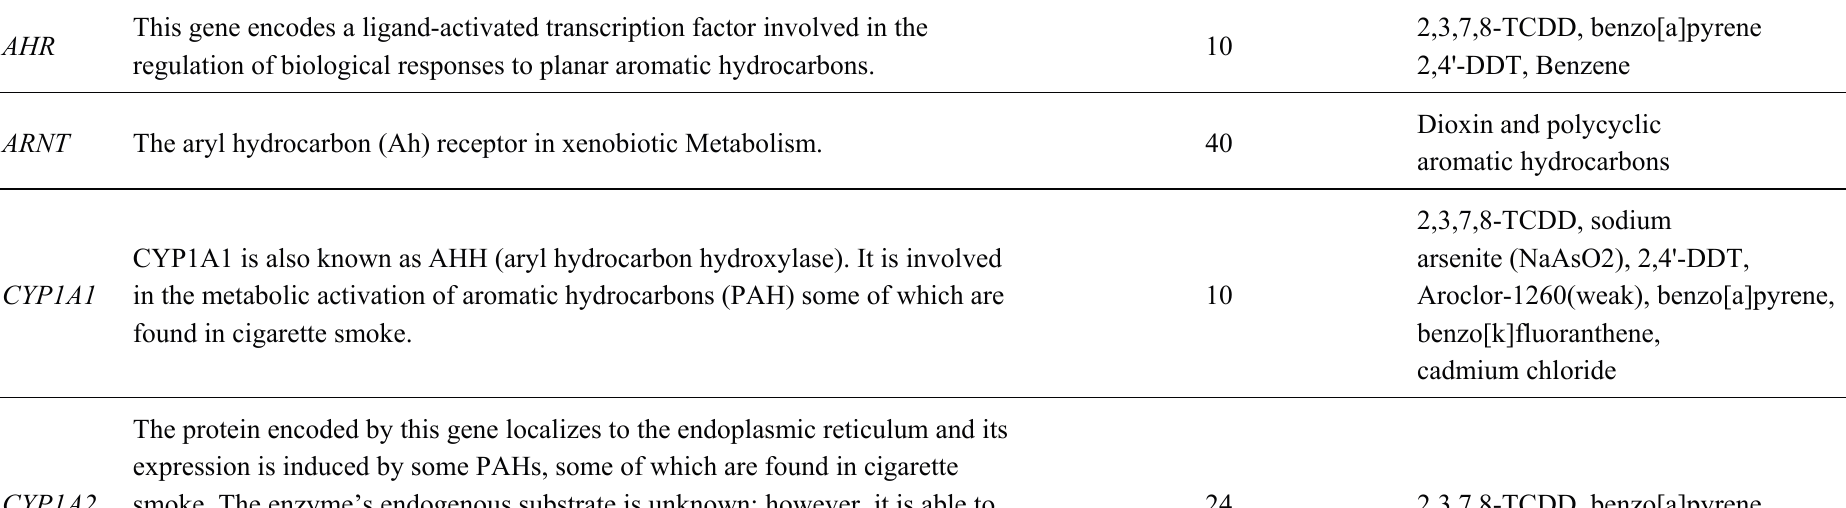
Table 1. Genes associated with a mutagenic chemical and minor allele frequency in the general population [19]. Genes Function and Variant Effects